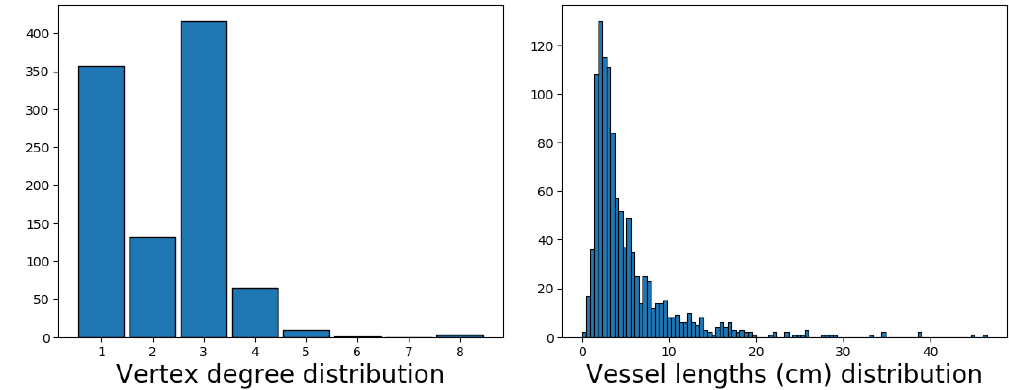
Figure 13. Topological characteristics of the skeleton network graph of the lymphatic system. ( Left ) Distribution of vertices degrees; ( Right ) distribution of edges lengths (note that these distributions refer to an intermediate model, and the final network graph model properties are presented in Section